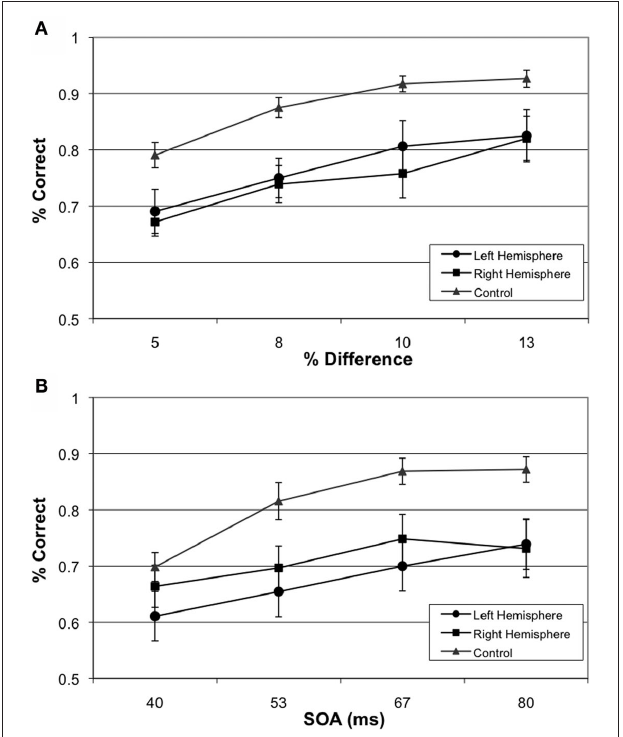
Figure 2 | group-wise Behavioral results. (A) Performance of left hemisphere involvement, right hemisphere involvement and age-matched participants on size judgment task and (B) Performance of left hemisphere involvement, right hemisphere involvement and age-matched participants on